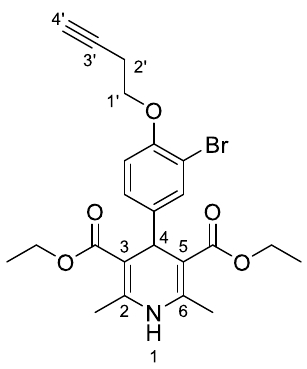
Figure 21. Chemical stucture of 3t .